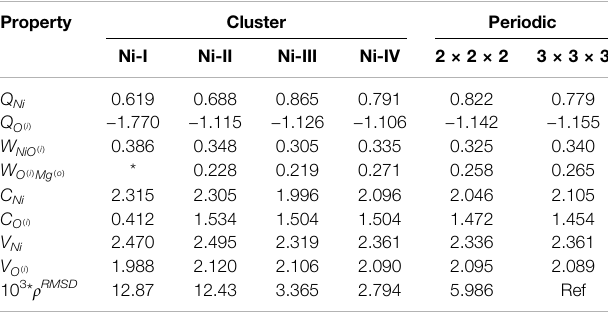
TABLE 3 | Electronic structure of clusters Ni:MgO. Table showing the convergences of Mulliken charges ( Q ), Wiberg bond indices ( W ), covalency ( C ), total valency ( V ) and integrated density difference Δ ρ (multiplied by a factor of 10 3 ) with respect to periodic values. * indicates that the value is unde fi ned for the particular